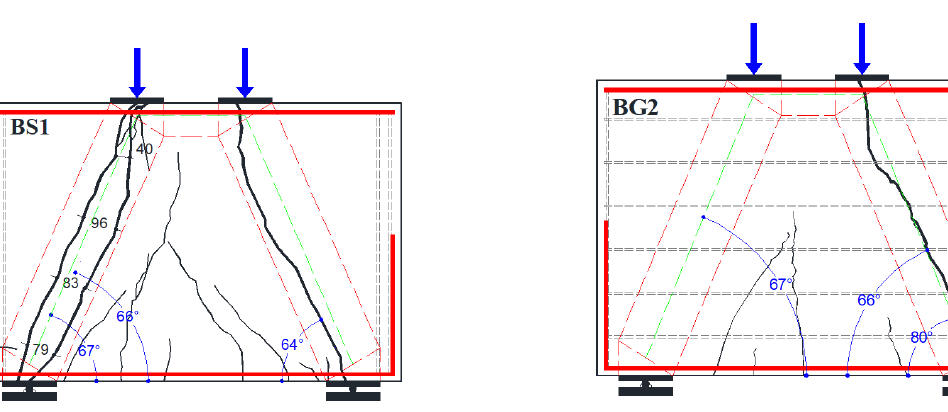
Figure 25: Crack pattern and mode of failure for a deep beam with- out web reinforcement